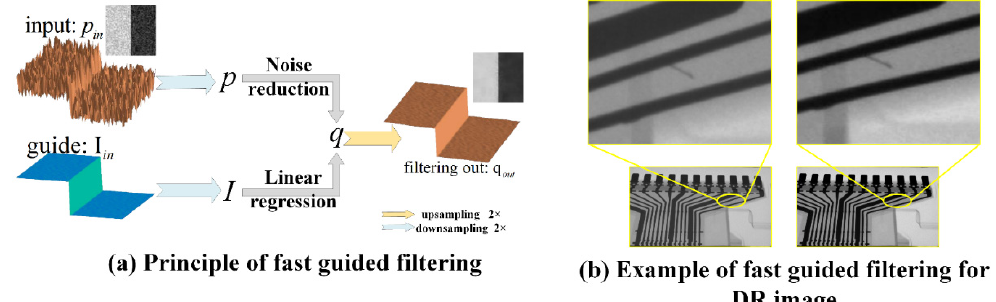
Figure 2. Fast guided filter principle ( a ) and its DR application example ( b ). Let the input image be p in and the filter guide image be I in , and their 2 × down sampling are p and I , respectively. q out is the 2 × up sampling of the filtered output q .